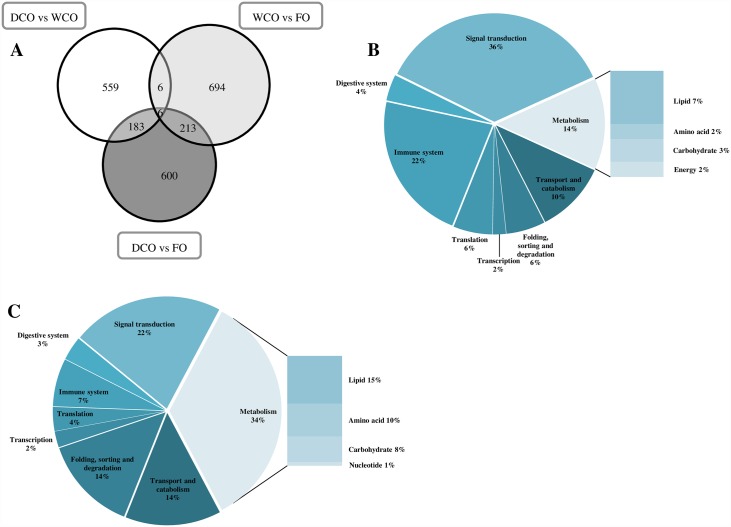
Impact of diet on liver transcriptome of Atlantic salmon fed a diet containing oil from transgenic Camelina (DCO) in comparison with those of fish fed diets containing fish oil (FO) or wild-type Camelina oil (WCO).Venn diagram representing mRNA transcripts differentially expressed in liver of Atlantic salmon fed the three diets with area of the circles scaled to the number of transcripts (Welch t-test, p < 0.05) (A). Distribution by category of common differentially expressed genes in liver of Atlantic salmon fed DCO compared to fish fed FO and WCO (B) or between Atlantic salmon fed FO compared to fish fed WCO and DCO (C).